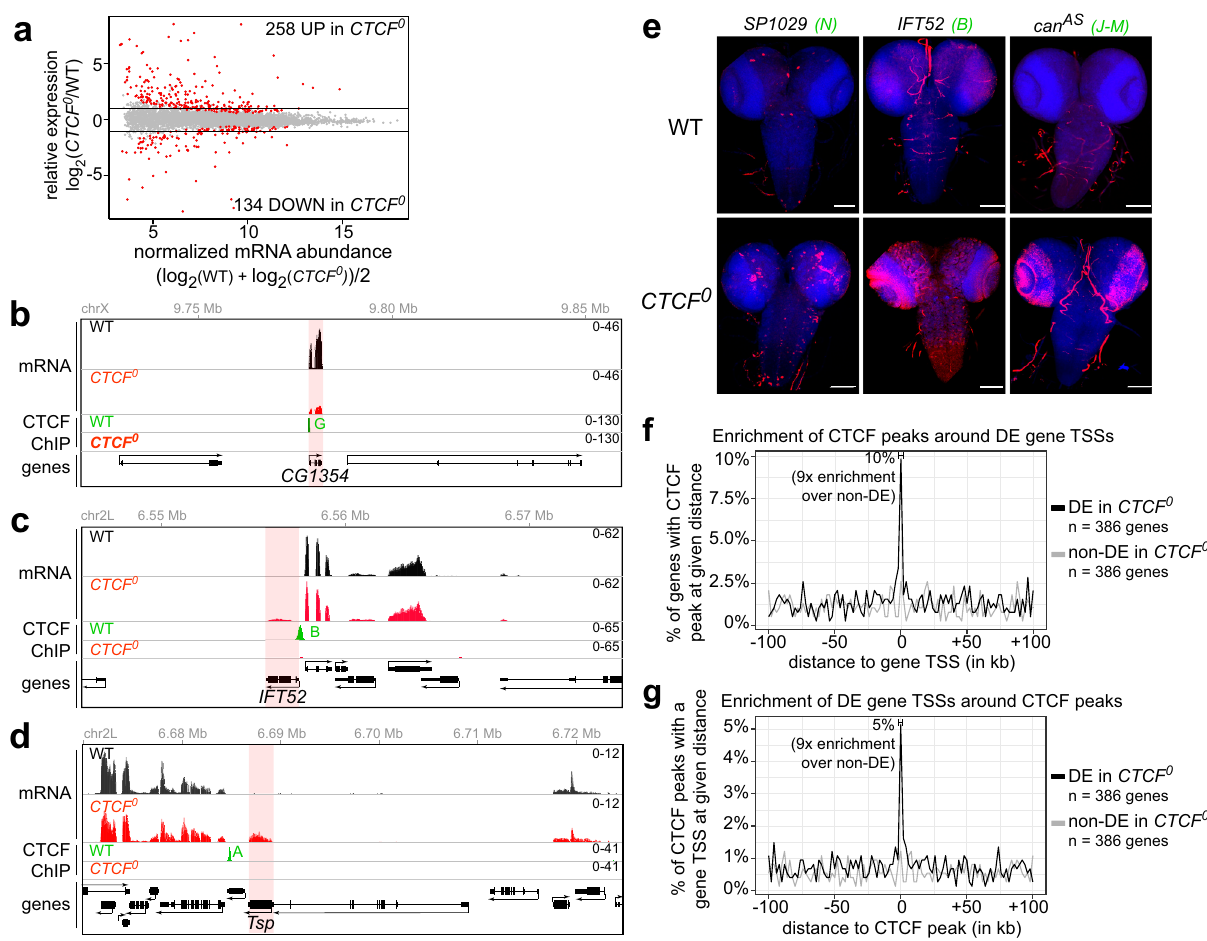
Fig. 3 CTCF impacts expression patterns of genes near CTCF peaks. a RNA-seq MA plot of CTCF 0 versus WT CNSs with mean abundance (in x) plotted as a function of enrichment (in y). Differentially expressed (DE) genes ( p adj < 0.05 and |fold change| > 1.5) are red. b – d RNA-seq signals in WT (black) and CTCF 0 (red) larval CNSs, and CTCF ChIP-seq signals in WT (green) and CTCF 0 (red) larval CNSs at CG1354 ( b ), IFT52 ( c ) and Tsp ( d ) loci. Differentially transcribed regions are shaded in red. Scales in tracks of all fi gures indicate reads per million. In all fi gures, CTCF peaks labeled by capital letters were tested in Fig. 4c. e RNA-FISH with antisense probes (red) against indicated transcripts in CNSs of wildtype and CTCF 0 larvae stained by DAPI (blue) (scale bars 100 µ m). mRNAs of SP1029 , IFT52 and an antisense transcript overlapping can (shown in Supplementary Fig. 3b) are normally not expressed in wildtype CNSs (background signal is sometimes visible in trachea) and are misexpressed in different patterns in CTCF 0 mutants. All animals showed similar misexpression patterns for a given transcript. f Percentage (in y) of n = 386 DE genes in CTCF 0 larval CNSs (black) or n = 386 randomly sampled expression-level-matched non-DE genes (gray) with at least one of 740 CTCF peaks at a given distance (per 2 kb bins) around the gene TSS, measured in the direction of transcription (in x). Ten percent of DE genes have at least one CTCF peak within ±1 kb of their TSS, which is ninefold higher than the average enrichment at the sampled non-DE genes. g Percentage (in y) of CTCF peaks with at least one of n = 386 DE gene TSSs (black) or n = 386 randomly sampled expression-level-matched non-DE gene TSSs (gray) at a given distance (per 2 kb bins) around CTCF peaks, measured in the direction of transcription (in x). Five percent of CTCF peaks have at least one DE gene TSS within ±1 kb, which is 9-fold higher than at the sampled non-DE